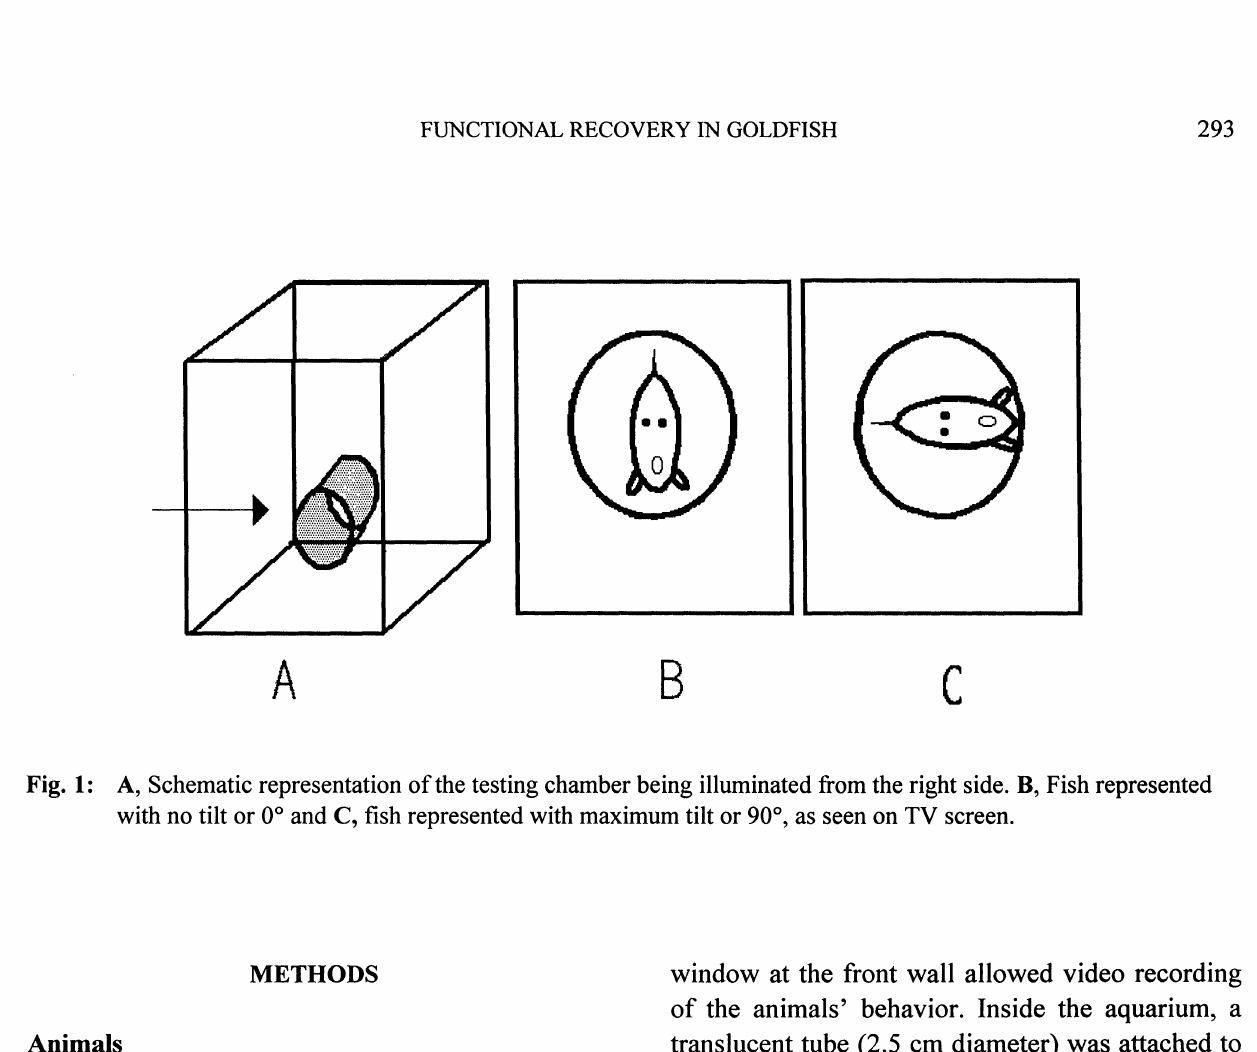
Fig. 1: A, Schematic representation of the testing chamber being illuminated from the right side. B, Fish represented with no tilt or 0 and C, fish represented with maximum tilt or 90